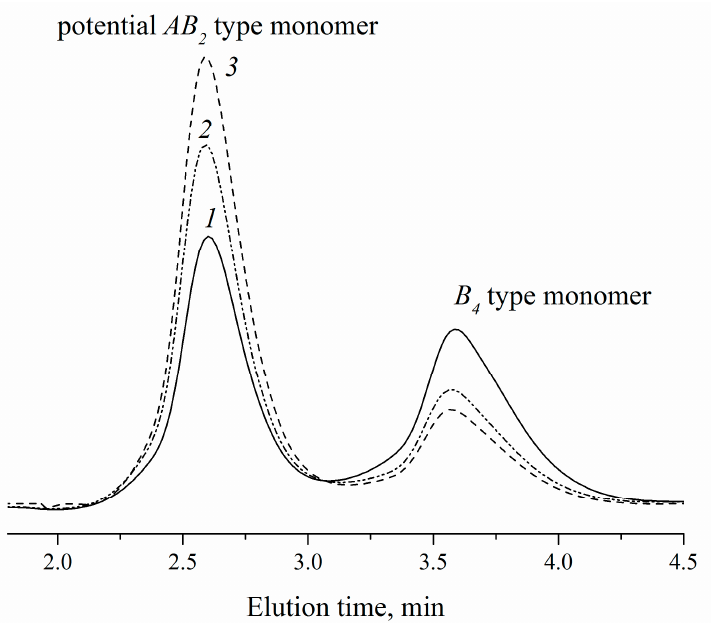
Figure 3. RPC for the products in reaction of IPDI with DAPOL, where the ratio [NCO] 0 /[OH] 0 was 1.35 ( 1 ) ,1.57 (2), and 1.66 (3).